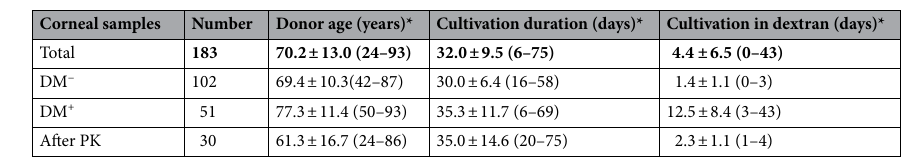
Table 2. Organ cultured corneal sample details. *All values are expressed as mean ± standard deviation (range).